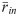
A) Analytical approximations for the nest I/O curves. B) Simulated nest I/O curves for different values of c. Each pair of error bars correspond to 10 simulation trials, each 5 minutes long, with a constant expected incoming rate and constant volatility c. The dashed black line represents points at which the mean incoming rate r¯in is equal to the mean outgoing rate r¯out.